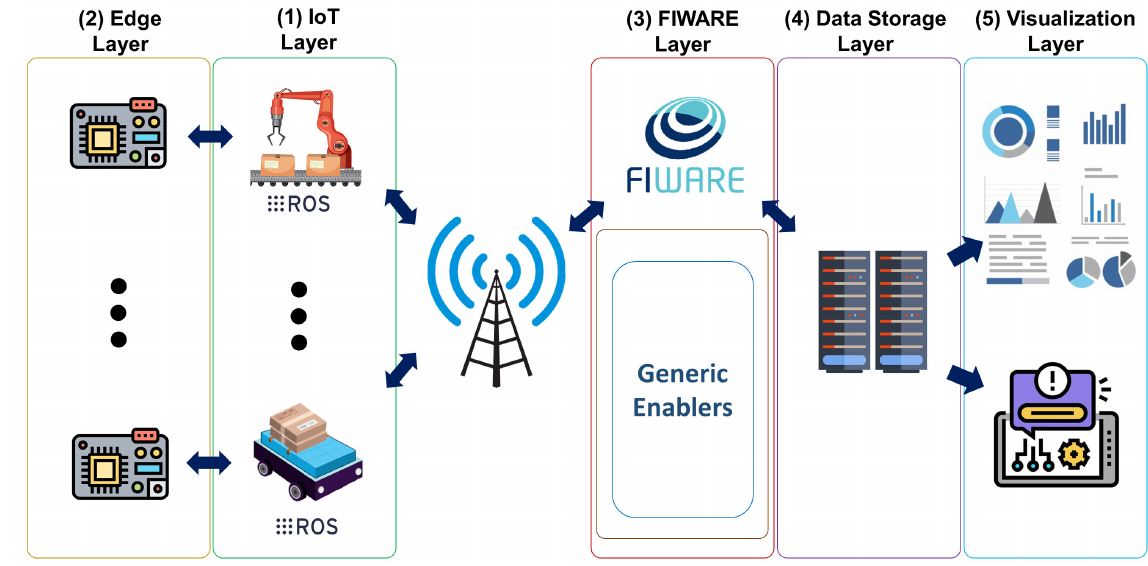
Figure 1. The proposed system architecture.